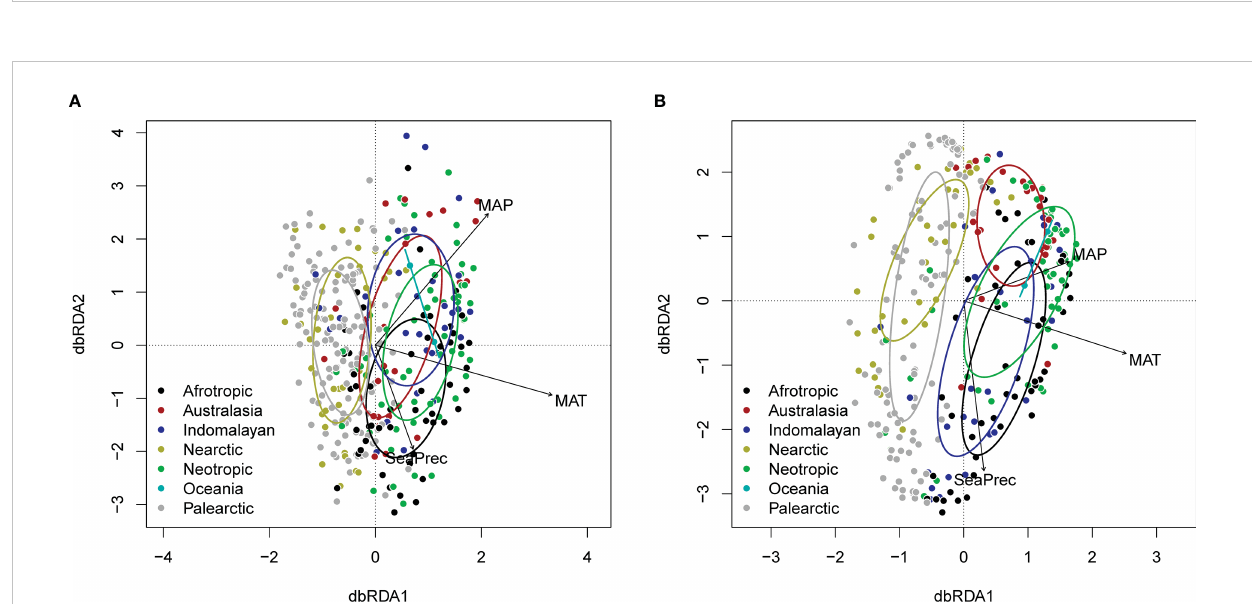
FIGURE 3 dbRDA plot (distance-based redundancy analysis) showing effects climatic variables (CHELSA) and biogeographic realm on (A) eDNA and (B) GBIF family level composition (following variance stabilising transformation). Ellipses indicate 1 standard deviation around the centroids for different biogeographic